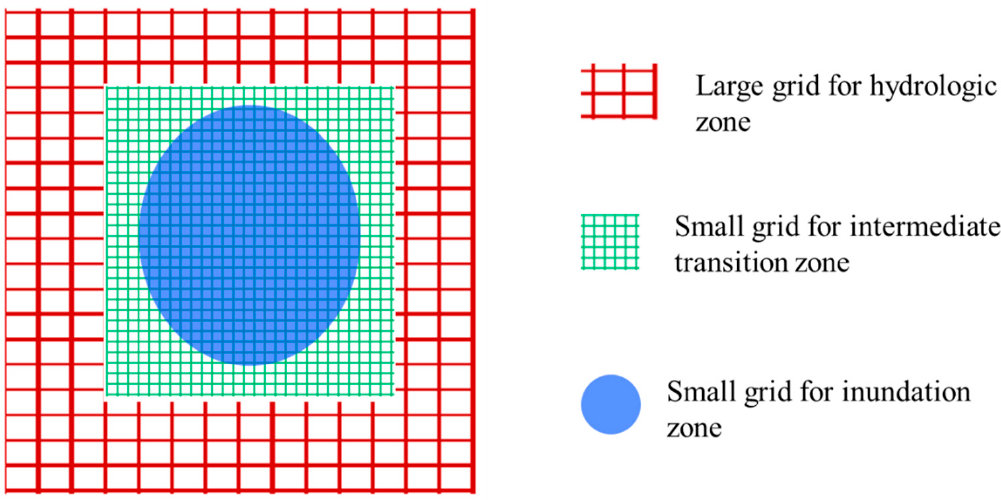
Figure 2. Schematic diagram of zone partition.